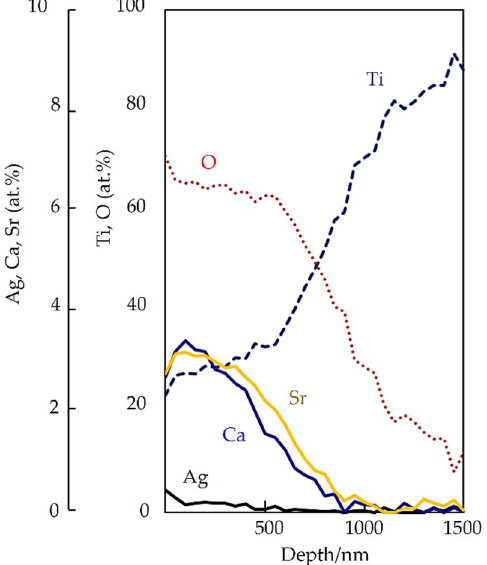
Figure 2. XPS depth profile of the surface of Ti subjected to NaOH‐Ca + Sr‐heat‐Sr + 1 mM Ag (pH = 4).